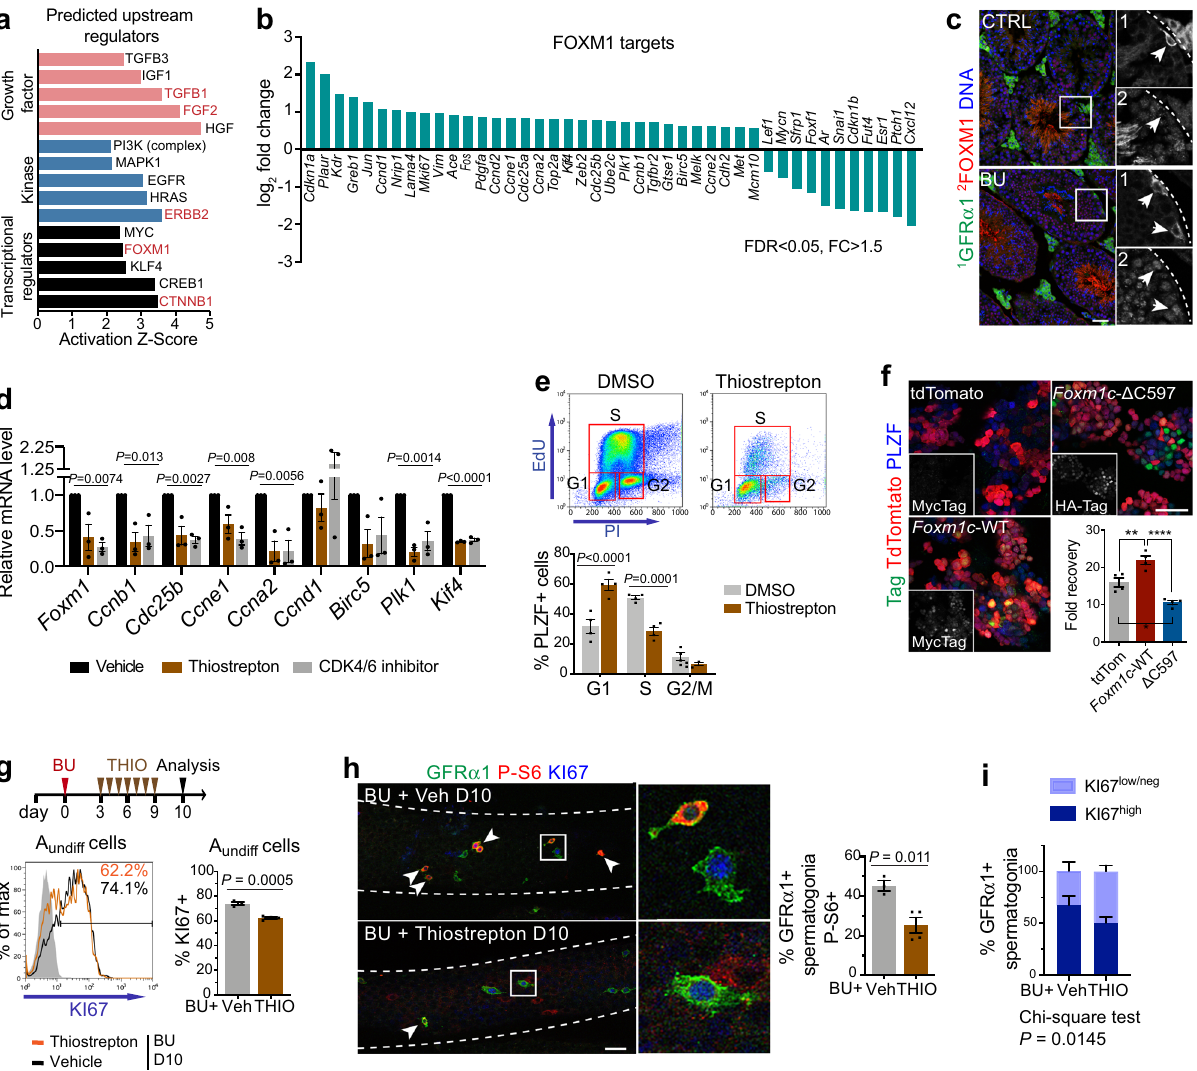
Fig. 6 Role of transcription factor FOXM1 in the regenerative response. a Predicted upstream regulator by IPA of DEGs from A undiff of CTRL and D10 BU- treated mice from Fig. 1e. Top 5 signi fi cant regulators in red. b FOXM1 targets identi fi ed from a differentially expressed in BU-treated samples. c Representative IF of testis cross-sections from CTRL and D10 post-BU mice ( n = 3 mice per group). Single channels of indicated regions are shown at higher magni fi cation. Arrows: GFR α 1 + spermatogonia. Dashed lines: Basement membrane. d RT-qPCR of cultured WT A undiff treated with inhibitors in complete medium for 20 h ( n = 3 independent cultures). Thiostrepton used at 10 μ M. Signi fi cance by one-way ANOVA. e Cell cycle analysis of WT A undiff cultures by fl ow cytometry. Cells treated as in d . Graph shows percentage of PLZF + cells in cell cycle phases ( n = 4 independent cultures) Signi fi cance by two-way ANOVA ( *** P < 0.001; **** P < 0.0001). f Representative IF of cultured A undiff overexpressing full-length (WT) Foxm1c , Foxm1c - Δ C597 or tdTomato as control. Graph shows cell recovery at D12 of culture ( n = 4 cultures). Signi fi cance by one-way ANOVA followed by Tukey ’ s multiple comparisons test (* P = 0.0114, ** P = 0.007, **** P < 0.0001). g Upper panel: treatment regimen and timeline for mice receiving FOXM1 inhibitor thiostrepton (THIO) after BU. Lower panels: representative fl ow cytometry of testis from D10 mice treated with BU then THIO or vehicle daily for 7 days from D3 post-BU. Graph shows percentage of A undiff KI67 + ( n = 3 vehicle, n = 4 THIO). h Representative wholemount IF of tubules from D10 mice treated as in g . Higher magni fi cation images of indicated regions are shown. Arrowheads: P-S6 + GFR α 1 + spermatogonia. Graph shows percentage of GFR α 1 + spermatogonia P-S6 + ( n = 3 vehicle, n = 4 THIO). Dashed lines: tubule outline. i Graph shows KI67 intensity within GFR α 1 + spermatogonia from h grouped into indicated levels using ImageJ (cut-off = 40) ( n = 3 vehicle, n = 4 THIO, >150 cells analysed per sample per group). Signi fi cance by two-sided χ 2 test. Scale bars, 50 μ m. Data presented as mean values ± SEM in d – i . Signi fi cance by two-tailed unpaired t test in g , h . Source data are provided as a Source Data fi le. of GFR α 1 + spermatogonia that were P-S6 + (Fig. 6h), indicating that FOXM1 promotes mTORC1 signalling in regenerative A undiff , a feature of the regenerative response. Suppression of mTORC1 by thiostrepton correlated with reduction in percentage of GFR α 1 + cells with high KI67 levels although did not affect abundance of GFR α 1 + cells (Fig. 6i and Supplementary Fig. 8i). Our data indicate that FOXM1 induction in A undiff following damage is NATURE COMMUNICATIONS| (2022) 13:2500